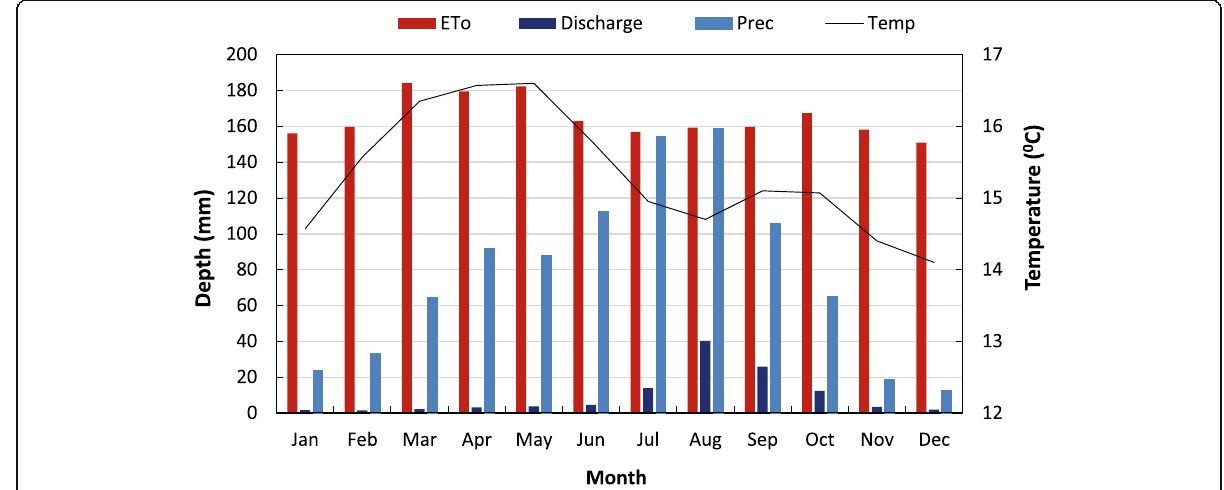
Fig. 3 Mean monthly temperature (Temp), evapotranspiration (ET 0 ), discharge, and precipitation (Prec)